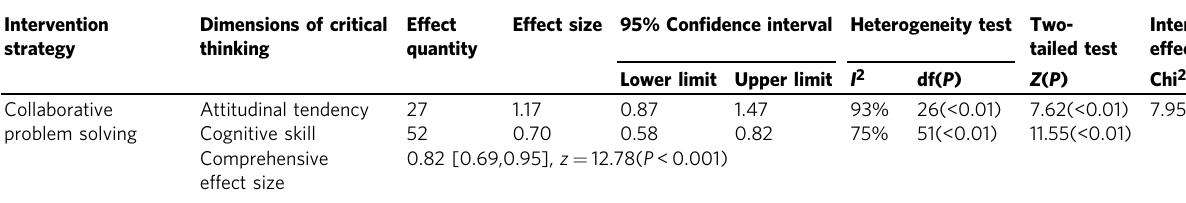
Table 3 Test results for critical thinking ’ s two dimensions.